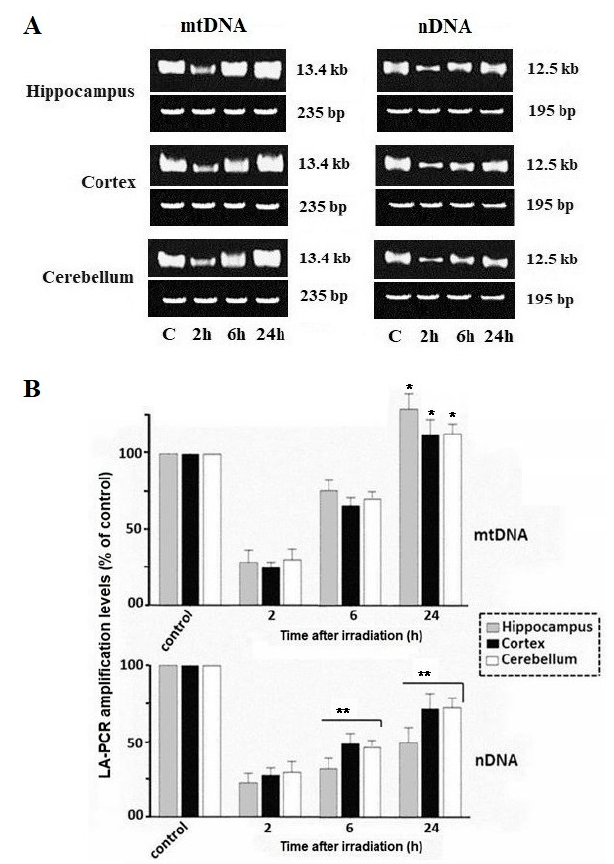
Figure 1. Analysis of damage and repair of mitochondrial DNA and nuclear DNA. Long fragments of mtDNA (13.4 kb) and nDNA (12.5 kb) were measured. These data were normalized by the measured levels of the short fragment of mtDNA (235 bp) and nDNA (195 bp), obtained using the same DNA sample. ( A ) Gel electrophoresis of the LA-QPCR products of nDNA and mtDNA extracted from rat brain regions at 2, 6, and 24 h after radiation exposure (here and in other figures, control: non-irradiated rats). ( B ) Quantitative analysis of the LA-QPCR amplicons of nDNA and mtDNA extracted from three rat brain regions at 2, 6, and 24 h after radiation exposure. The data are presented as mean ± SD from 4–5 independent experiments. Statistical significance was set at * p < 0.05, ** p < 0.01.